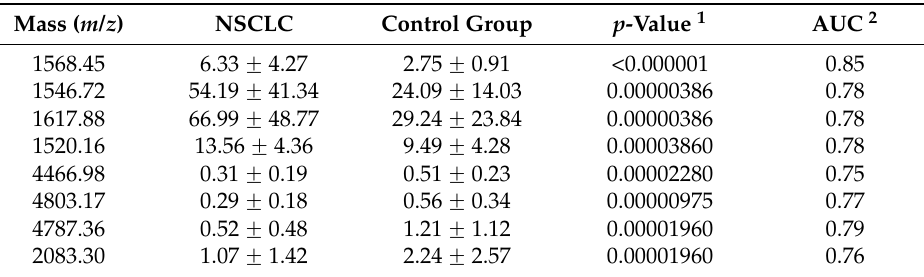
Table 2. Intensities (mean ˘ SD) and results of the univariate statistical analyses of the most discriminating peptide ions determined in serum of non-small cell lung cancer patients (NSCLC) ( n = 90) and control group ( n =